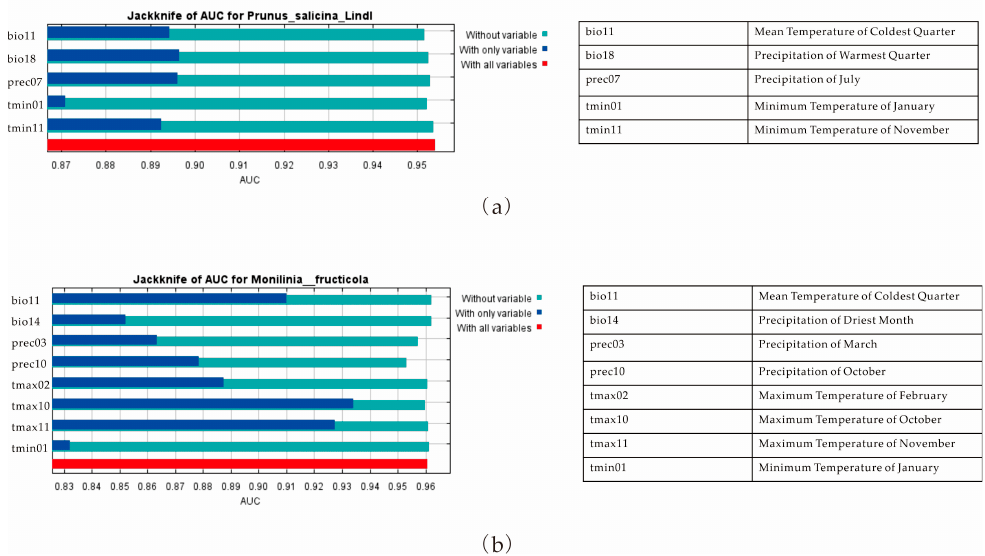
Figure 2. ROC curve and AUC values for the reconstructed model for P. salicina ( a ) and M. fructicola ( b ).